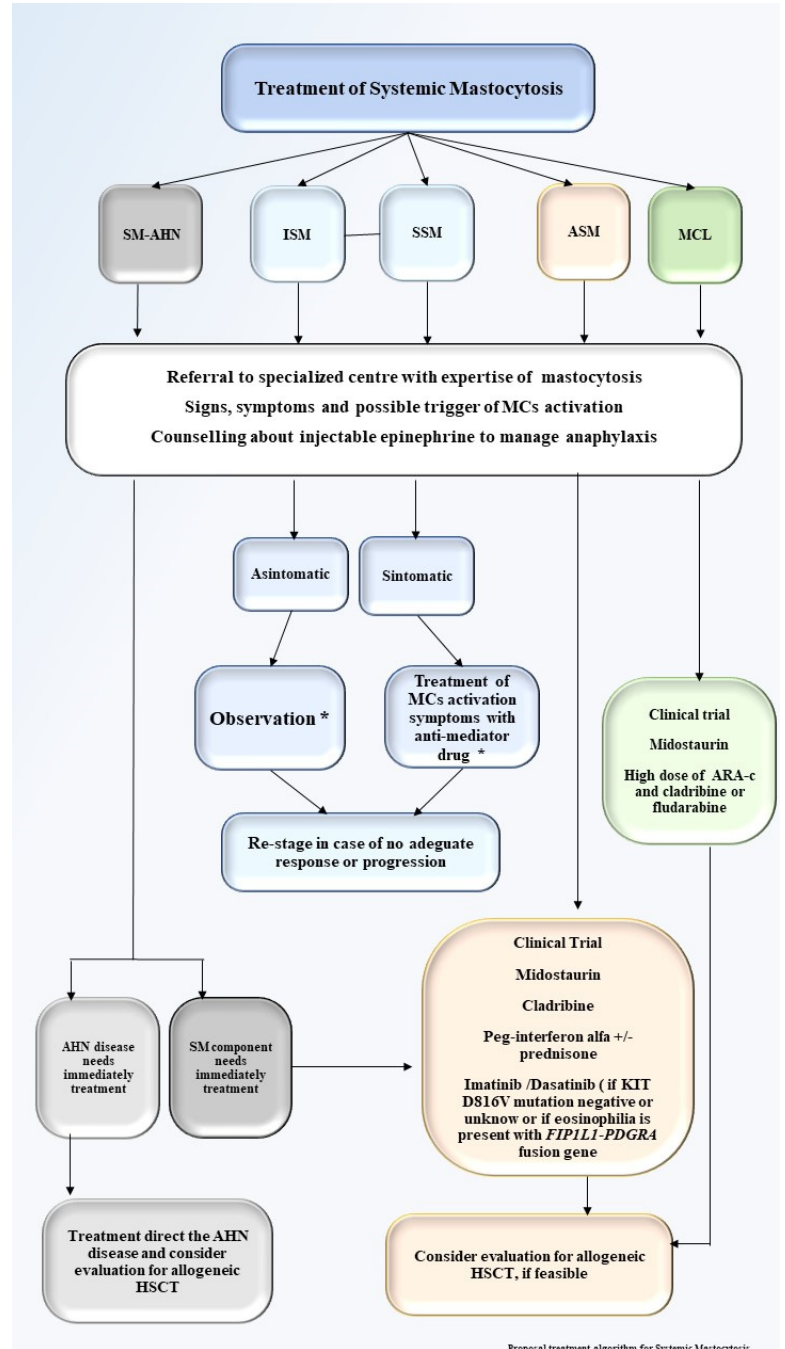
Figure 4. Proposal treatment algorithm for systemic mastocytosis. Proposal treatment algorithm for systemic mastocytosis. SM-AHN, systemic mastocytosis associated a hematological neoplasm; ISM, indolent systemic mastocytosis; SSM, smoldering systemic mastocytosis; ASM, aggressive systemic mastocytosis; MCL, mast cell leukemia; HSCT, hematopoietic stem cell transplant; * Enroll patients in clinical trial, if